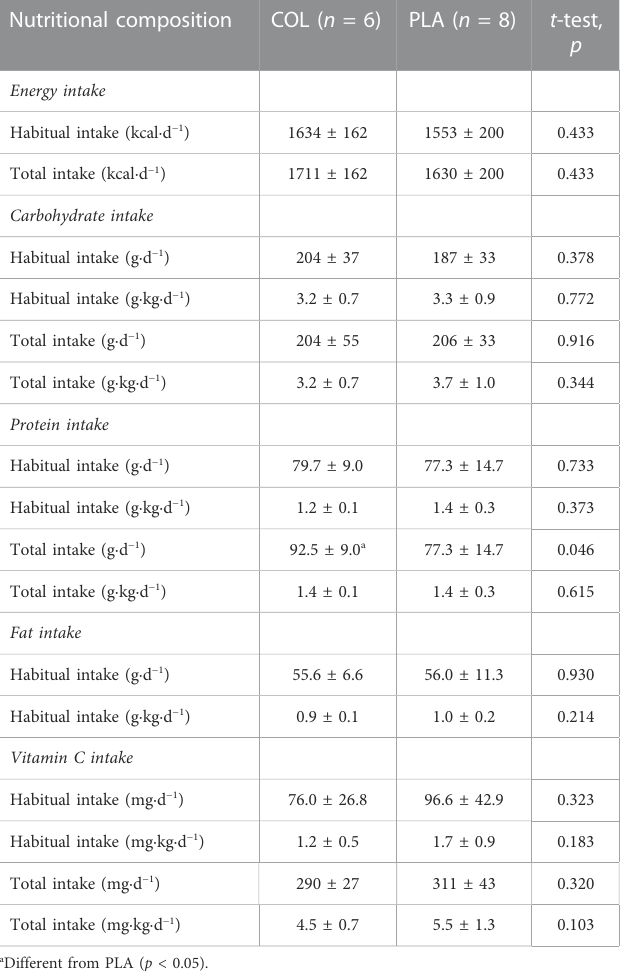
TABLE2Energy,macronutrient,andmicronutrientintakeduringthepre-training assessment period. Data are mean ± SD. Nutritional